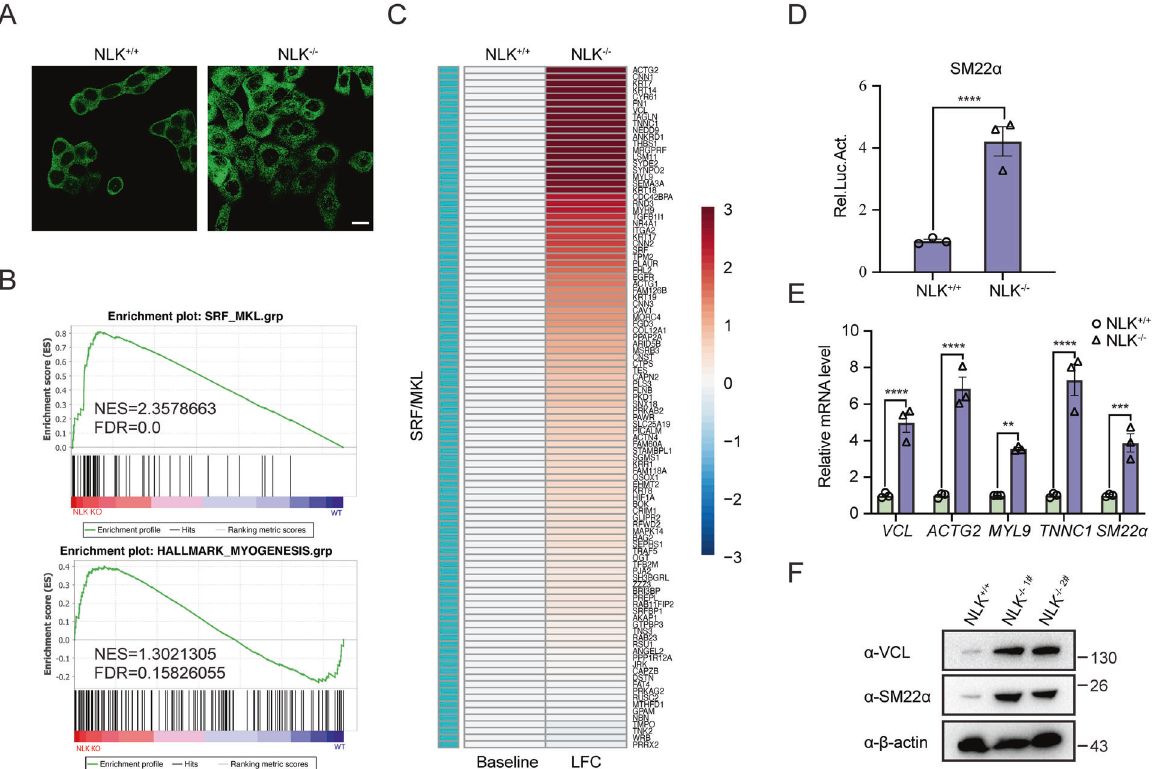
fl uorescence microscopy. Scale bar, 10 μ m. B GSEA showing SRF/MKL and myogenesis signaling enrichment between wild-type and NLK- de fi cient HCT116 cells. C Heatmap showing the differentially expressed genes involved in SRF/MKL signaling between wild-type and